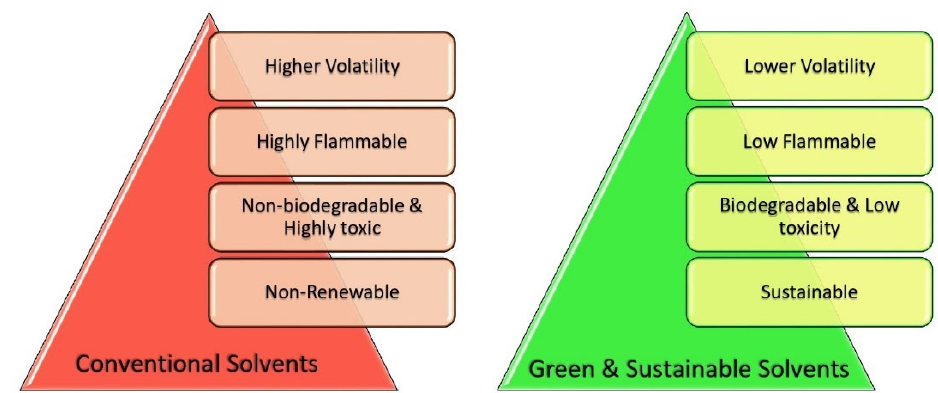
Figure 1. Merits of green and sustainable solvents over conventional solvents.